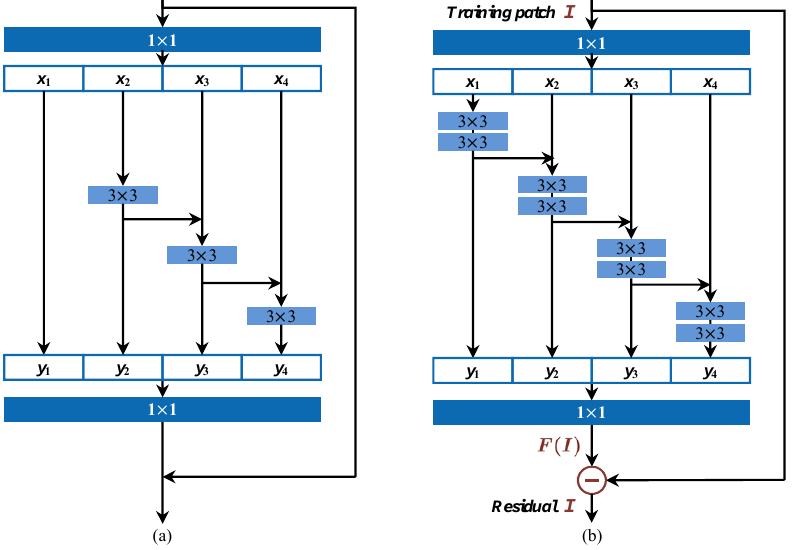
Figure 3. Network structures of the ( a ) Res2net. Reprinted with permission from ref. [42] Copyright 2019 IEEE and ( b ) the proposed residual prediction